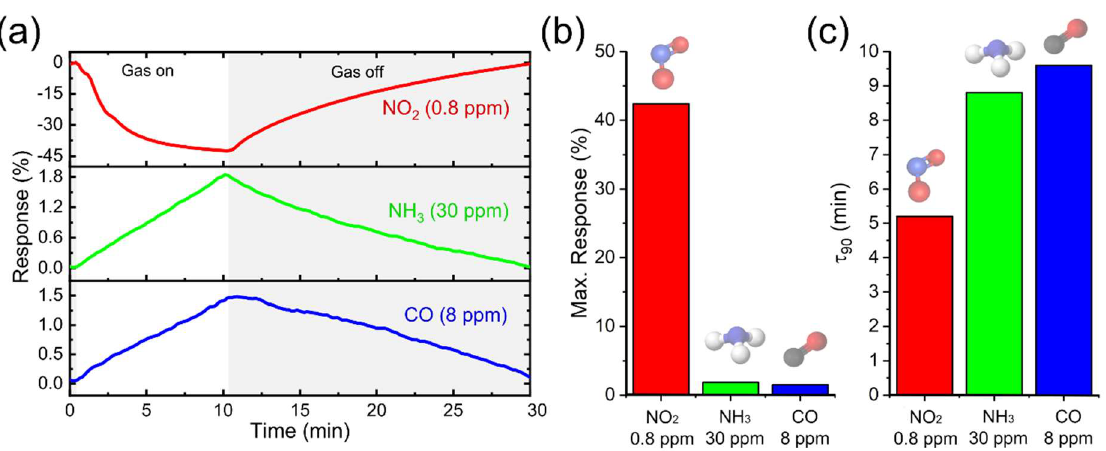
Figure 5. ( a ) Real time responses, ( b ) maximum (absolute value) responses and ( c ) response time, τ 90 , of the paper-based sensor to 0.8 ppm of NO 2 (red), 30 ppm of NH 3 (green), and 8 ppm of CO (blue).